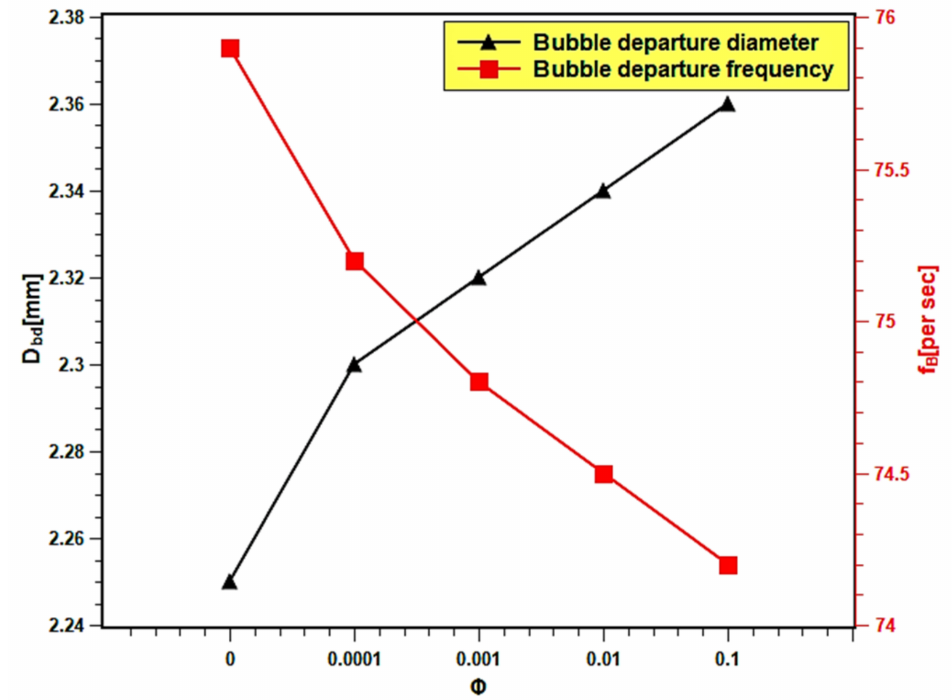
Figure 16. Bubble departure diameter and bubble frequency variation with